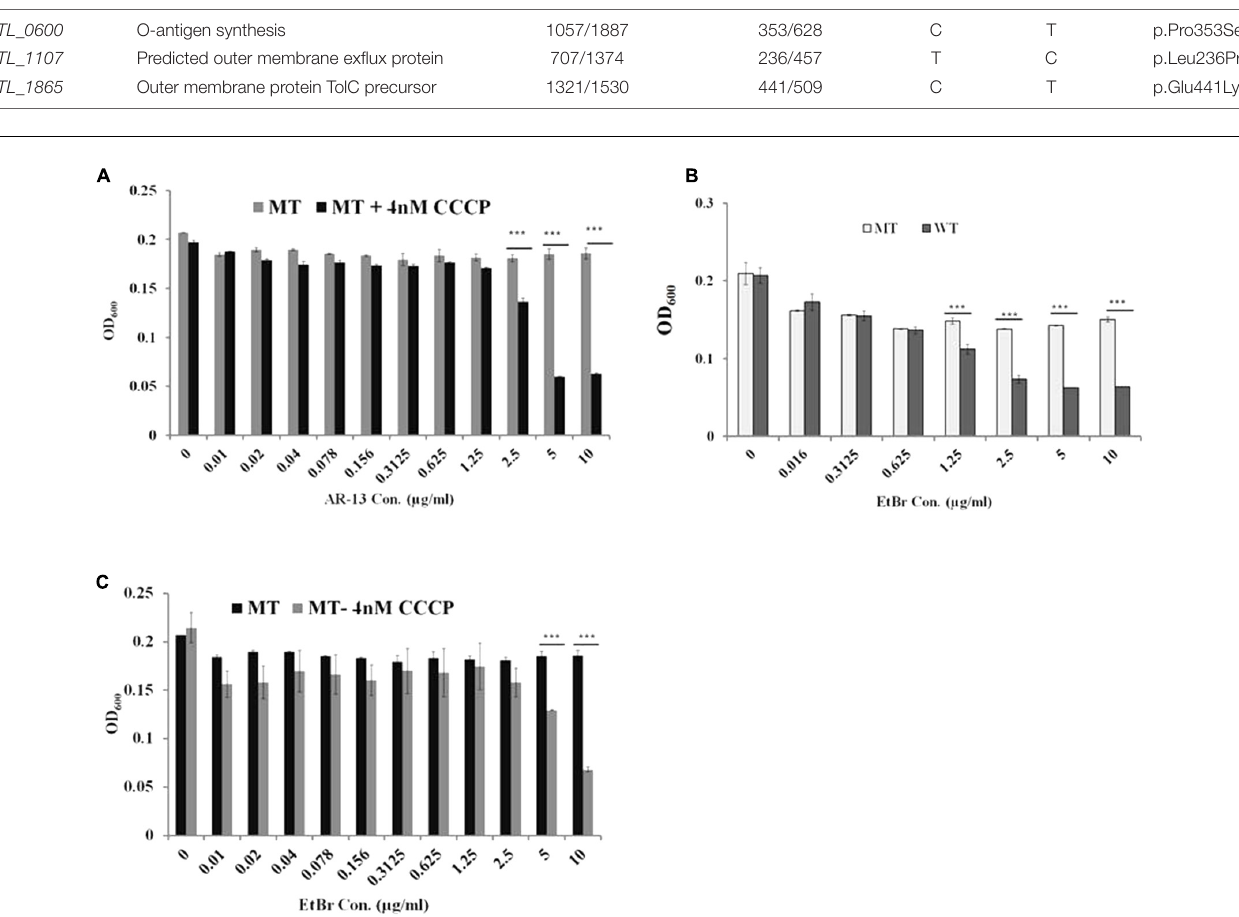
FIGURE 5 | Efflux pumps mediate AR-13 resistance in LVS. Efflux pump inhibitor CCCP sensitizes the AR-13 resistant (AR-13 r ; MT) mutant to AR-13. (A) The MT was grown in twofold serial dilutions of AR-13 with or without a sub-inhibitory concentration of CCCP (4 nM, see Supplementary Figure 4 for more